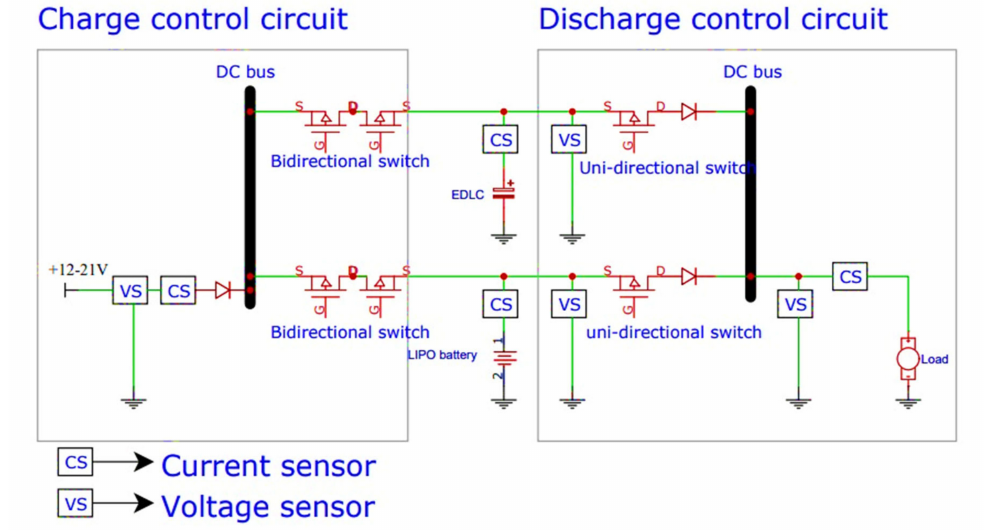
Figure 2. Schematic of fully active battery–supercapacitor